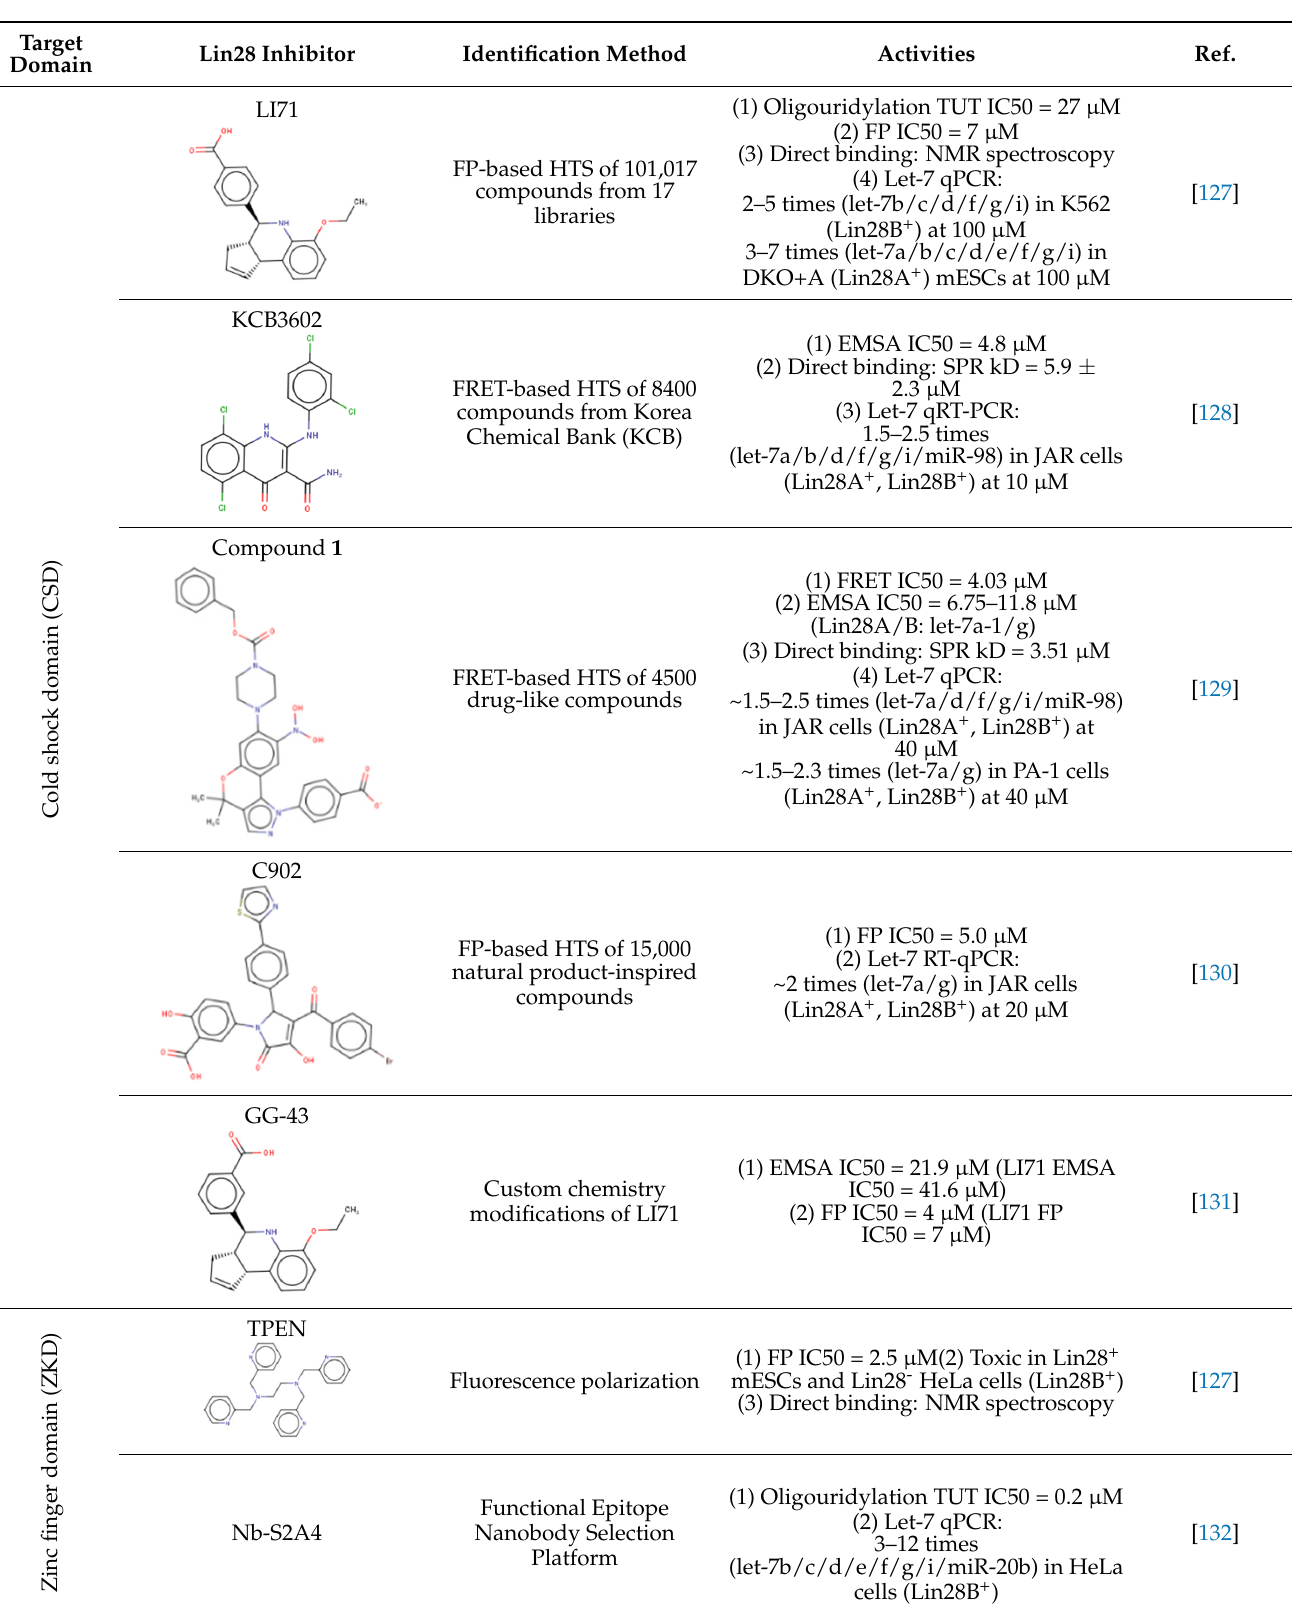
Table 2. Lin28 inhibitors. Lin28A and B expression in human cancer cell lines was confirmed from the Cancer Cell Line Encyclopedia (CCLC) Dependency Map